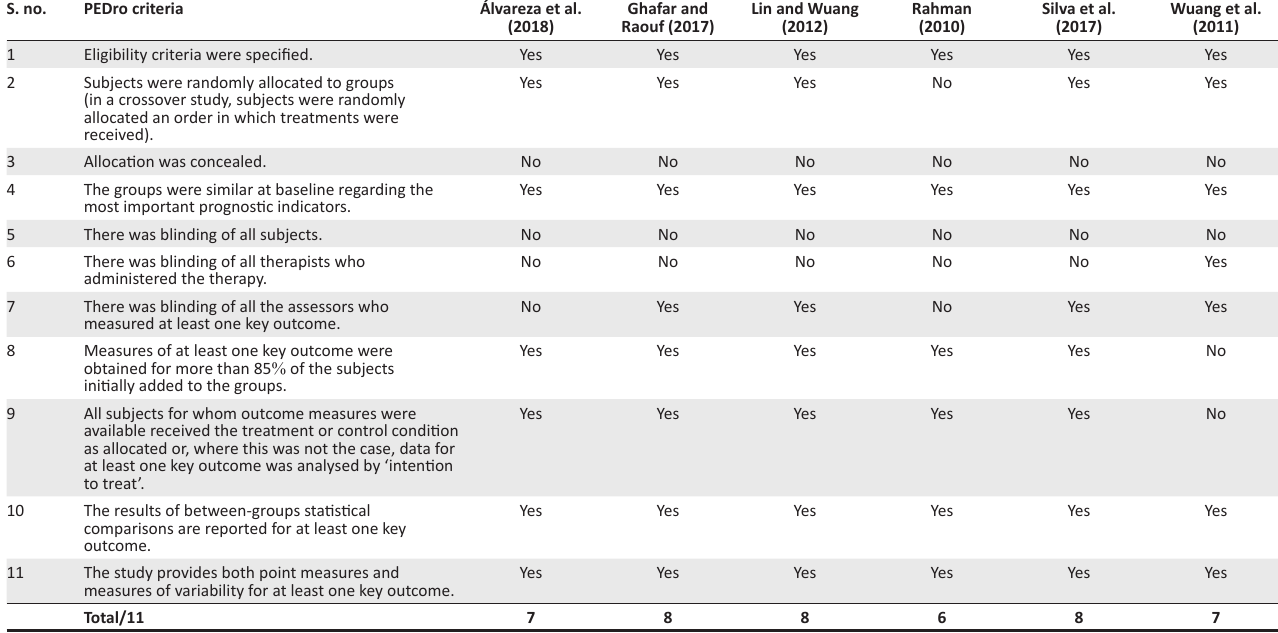
TABLE 1: Methodological quality of included studies. S.